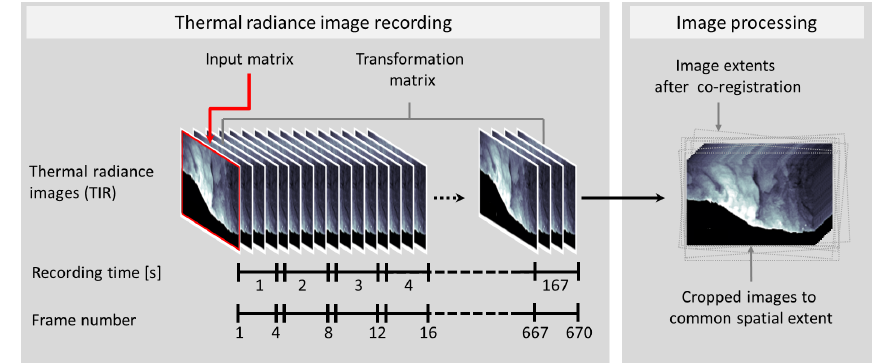
Figure 2. Graphic illustration of image recording and image preprocessing applied during the presented approach.